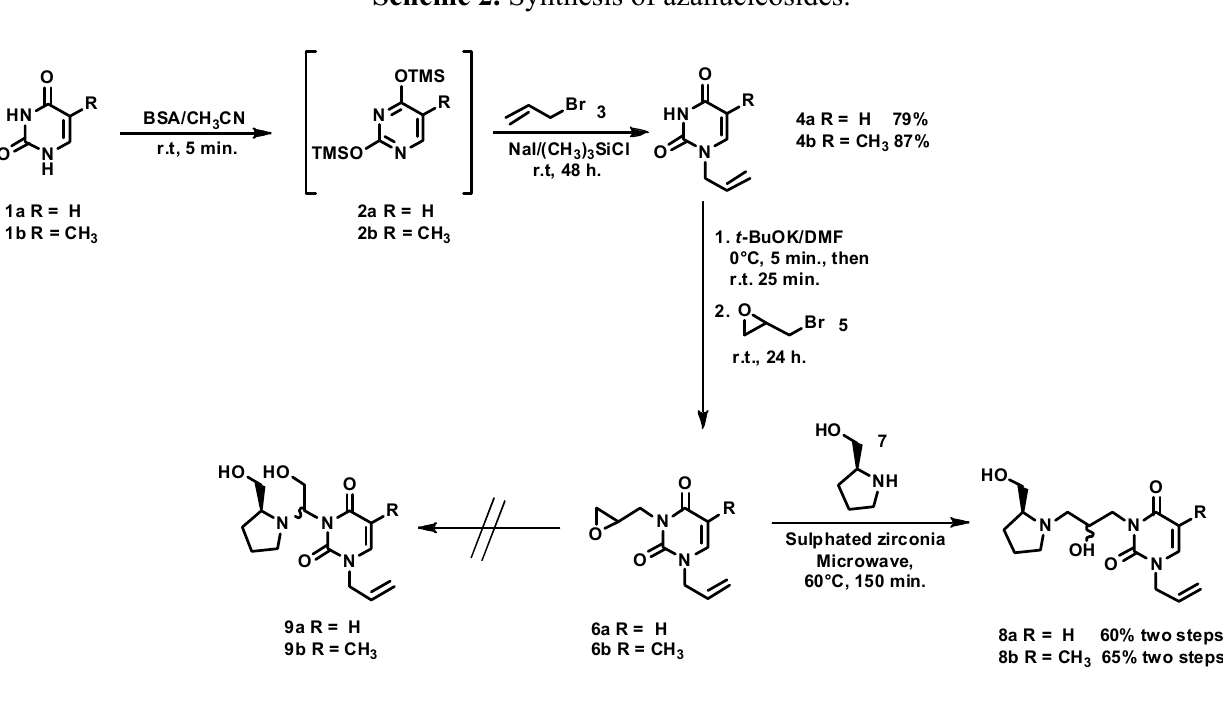
Scheme 2. Synthesis of